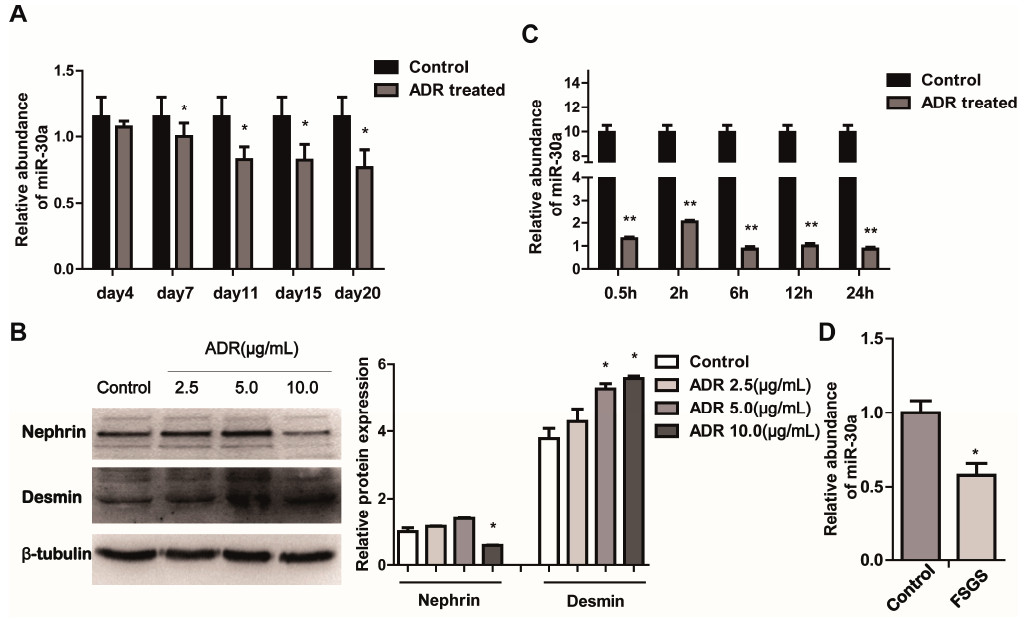
Figure 1. MiR-30a is Downregulated in Podocyte Injury. ( A ) RT-qPCR analysis of miR-30a expression levels in glomeruli from BALB/c mouse after Adriamycin (ADR; 10.5 mg/kg) injection for 4, 7, 11, 15 and 20 days ( n = 3, mean ± SD); ( B ) Western blot analysis of Nephrin and Desmin expression levels in cultured MPC5 cells treated with ADR at different doses (2.5, 5.0 and 10.0 µg/mL); Quantitative analysis of Nephrin and Desmin protein levels after normalization with β -tubulin; ( C ) RT-qPCR analysis of miR-30a expression levels in cultured MPC5 cells treated with ADR (5.0 µg/mL) at different time points (0.5, 2, 6, 12 and 24 h); ( D ) RT-qPCR analysis of miR-30a expression levels in the glomeruli from one patient with focal segmental glomerulosclerosis (FSGS) and one patient with kidney rupture (Control). The relative amount of miR-30a was normalized to U6. All data are presented as means ± SD from three independent experiments. * p < 0.05, ** p < 0.01, indicate statistically significant and highly statistically significant differences,